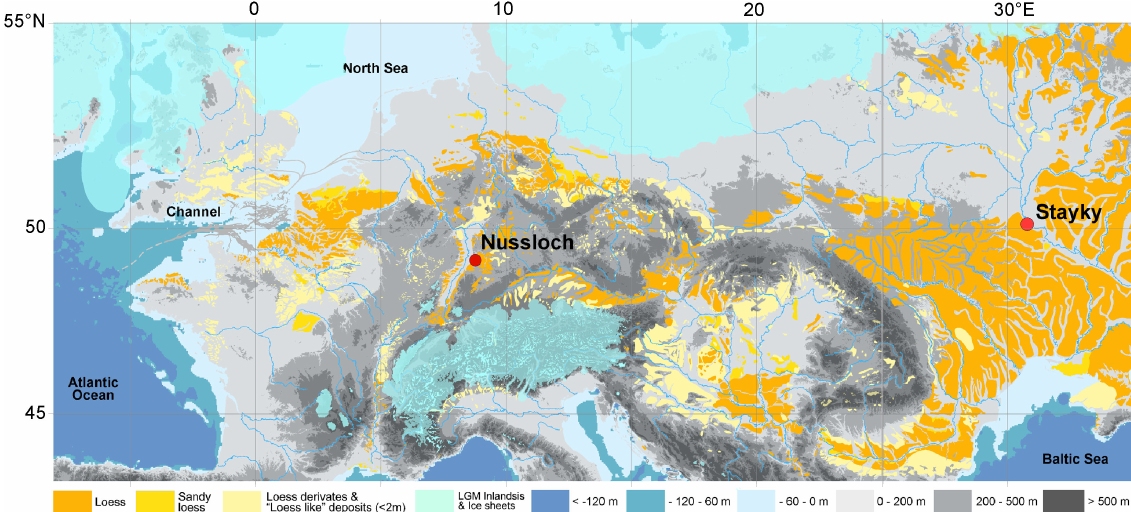
Fig. 1. Map of the thickest European loess deposits (in yellow), in the context of the Last Glacial Maximum (21kyrBP) ice sheets (light blue) and sea level (modified from Antoine et al., 2013, based on data from compilations kindly provided by D. Haase from Haase et al., 2007, and J. Ehlers from Ehlers et al., 2011). Blue/gray colors indicate depth/elevation with respect to the actual sea